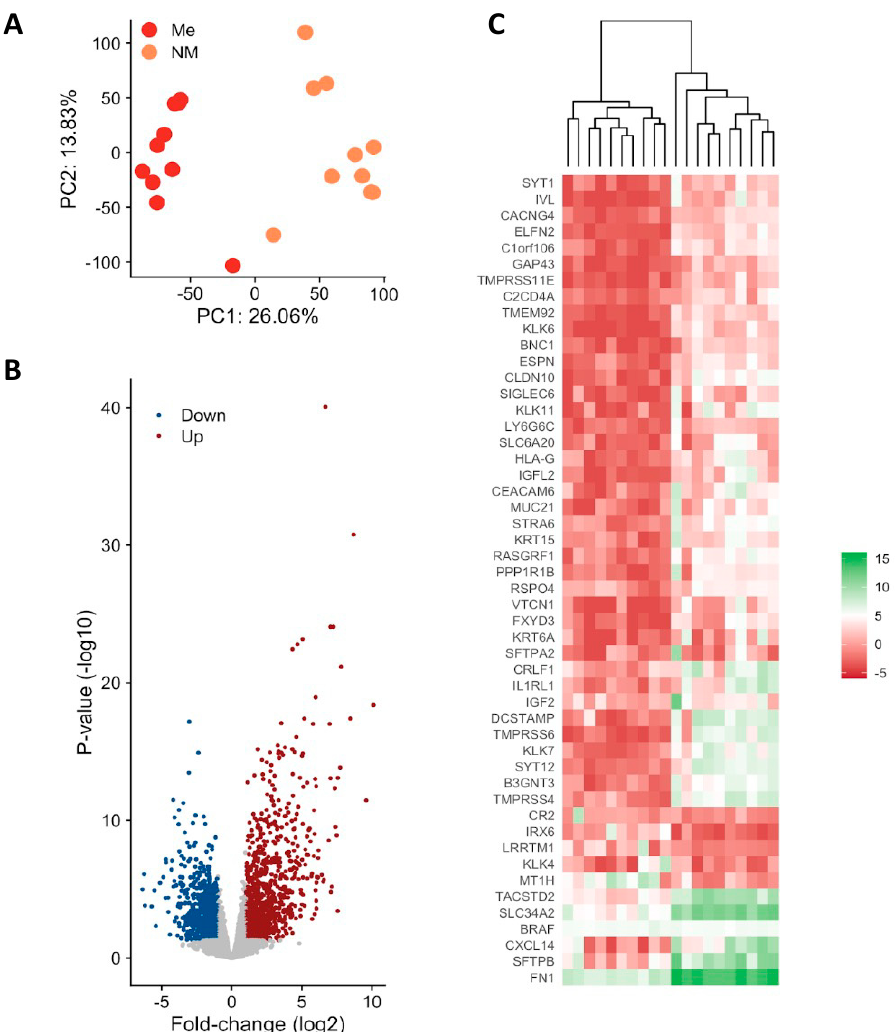
Figure 1. Differential gene expression in metastatic (Me) vs. non-metastatic (NM) PTC. ( A ) Principal component analysis (PCA). PCA plot of all RNA-Seq samples. Replicates of the same group are indicated by the same color as shown in the legend ( B ) Volcano plot of differentially expressed genes ( C ) Observed gene expression (log CPM) of all differentially expressed genes in all samples profiled shown as a Heatmap. Each column represents a sample, and each row represents a differentially expressed gene (DEGs). Upregulated genes are shown in red and downregulated genes are shown in blue. Scheme A was created using Biorender Free Software (https://biorender.com/ accessed on 1 January 2022).